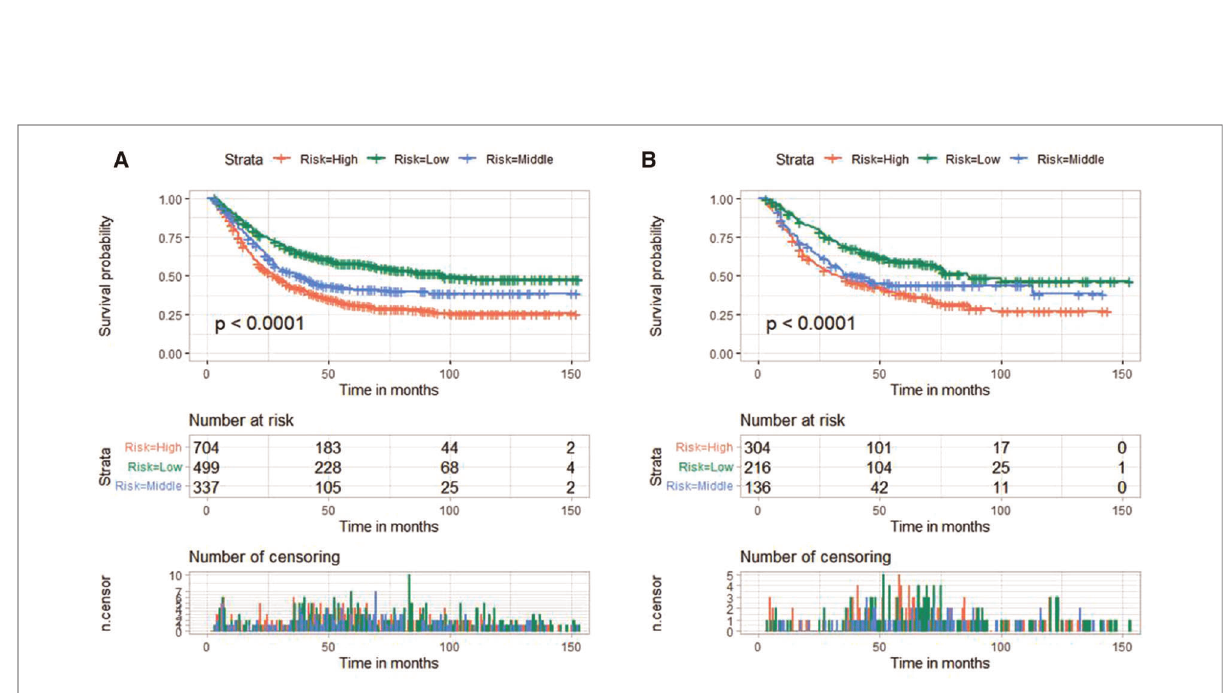
FIGURE 7 Risk strati fi cation based on nomogram score and Kaplan-Meier curves for cancer-speci fi c survival in training cohort ( A ) and validation cohort ( B